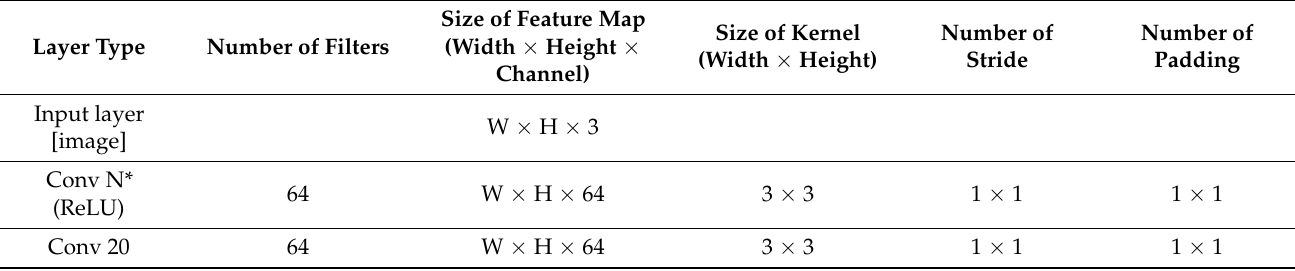
Table 3. Architecture of VDSR. (Conv refers to a convolution layer. Here, N* indicates a number from 1 to 19. ReLU refers to a rectified linear unit. VDSR uses an original image with unfixed width and height; thus, W and H are